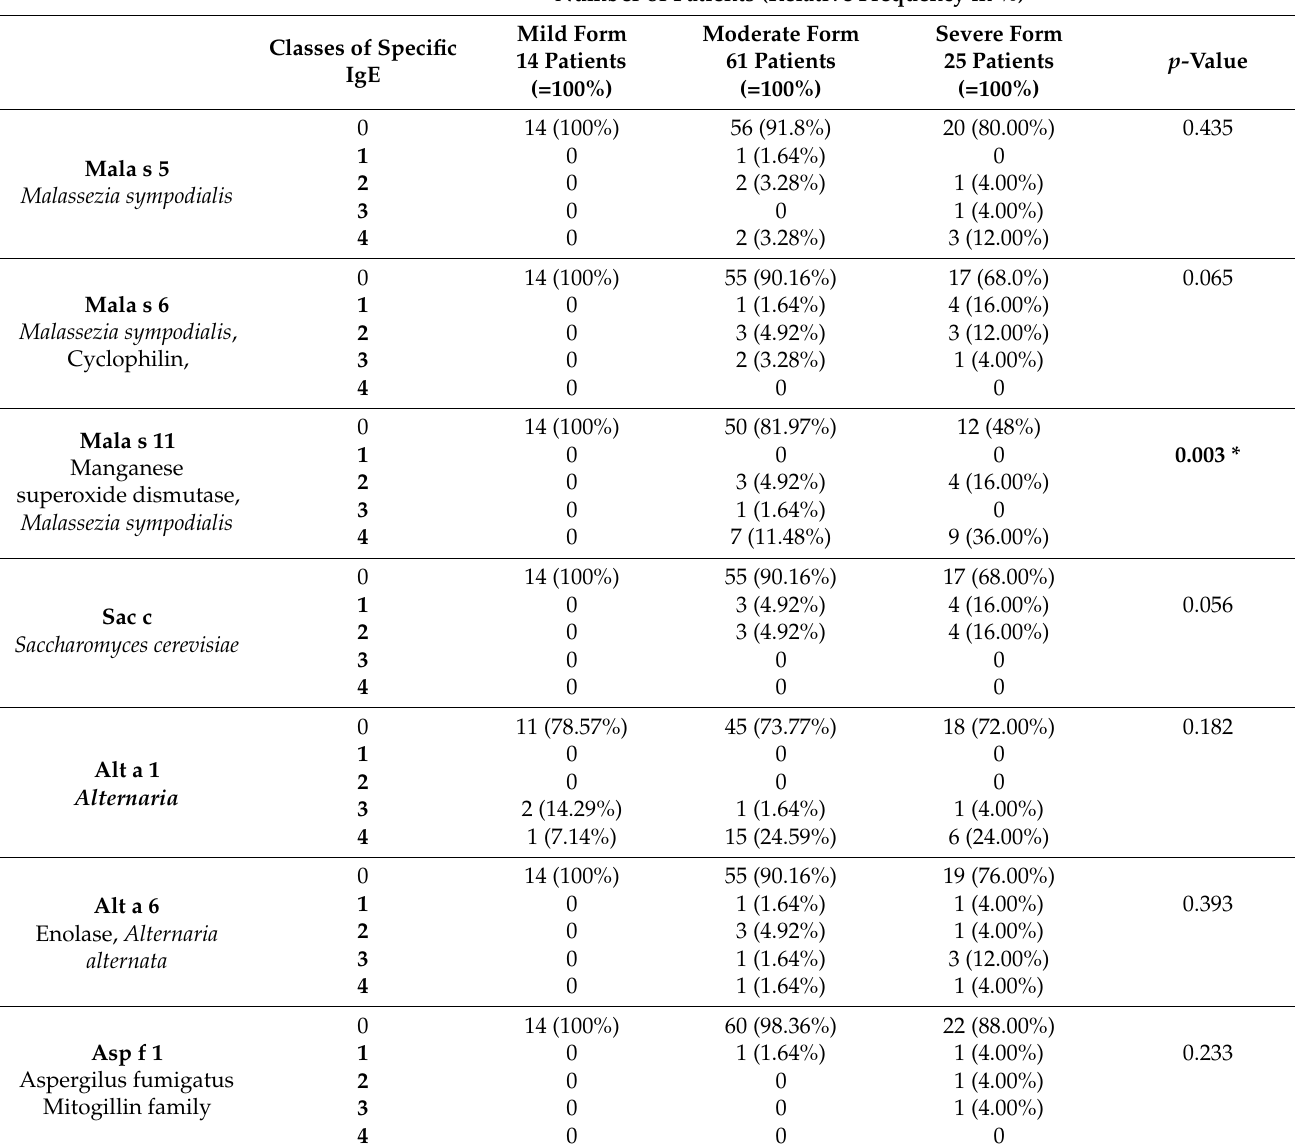
these molecular components and allergen extract: Mala s 11 ( p -value = 0.00342), Asp f 3 ( p -value = 0.00479), Asp f 4 ( p -value = 0.04229), Cla h (p -value = 0.01598) and Cla h 8 ( p -value = 0.02364). Although we have not confirmed the significant relation between the severity of AD and the level of specific IgE (classes 0–4) to Mala s 6, Asp f 6 and to allergen extract Sacc according to the level of specific IgE (classes 0, 1, 2, 3, 4), this difference being nearly significant ( p -value = 0.064091 for Mala s 6, p -value =0.05590 for Sacc and p -value = 0.05773 for Asp f 6), Table 4. Table 4. The number of patients according to the classes of specific IgE to molecular components and allergen extracts of yeast and molds and according to the severity of AD (mild, moderate, severe form). The relative frequency of sensitization in the classes of specific IgE 0–4 in patients suffering from mild, moderate and severe form of AD is recorded. The significance level was set to 5%. The significant difference ( p -value < 0.05) is shown extra bold *, the statistical analysis is made with Fisher´s exact test. The measuring range for specific IgE is 0.3–50 kU A /L (quantitative) and for total IgE is 1–2500 kU/L (semiquantitative). The results are expressed as Class 0 (<0.3 kU A /L—negative), Class 1 (0.3–1 kU A /L—low level), Class